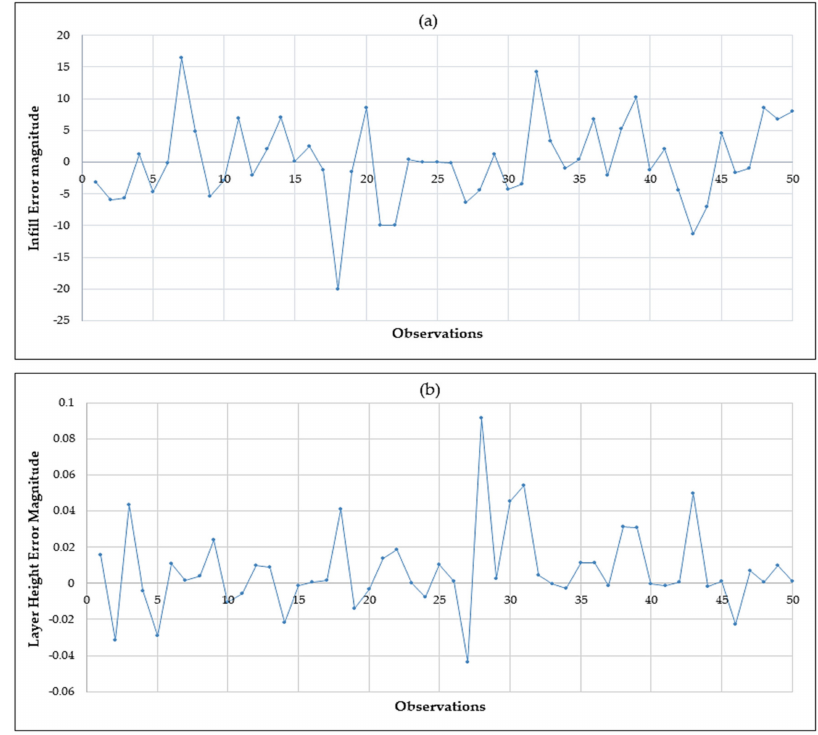
Figure 16. Error magnitude of the predicted data: ( a ) infill; ( b ) layer